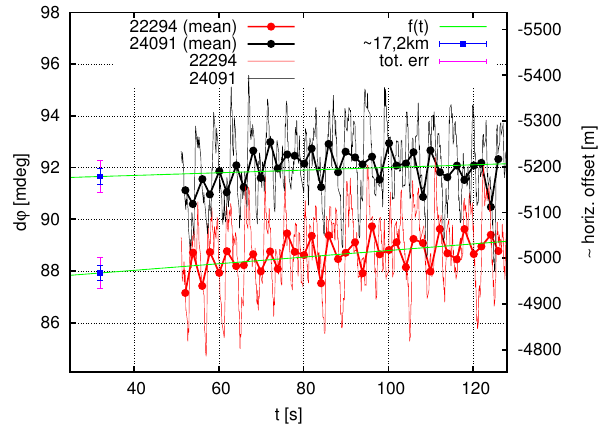
Fig. 12. Fitted AAOs versus measurement time for the occulta- tion state for two of the orbits already used in Fig. 6: 22022 (17 May 2006), and 24091 (9 October 2006). The thin lines in- dicates the individual readouts, the points are the mean over one scan. Added are the linear fits ( f (t) ) through these values. The blue square marks the extrapolated EAO at 17.2km with the fit error. The violet error bar indicates the total error of the EAO at this altitude (see Sect.